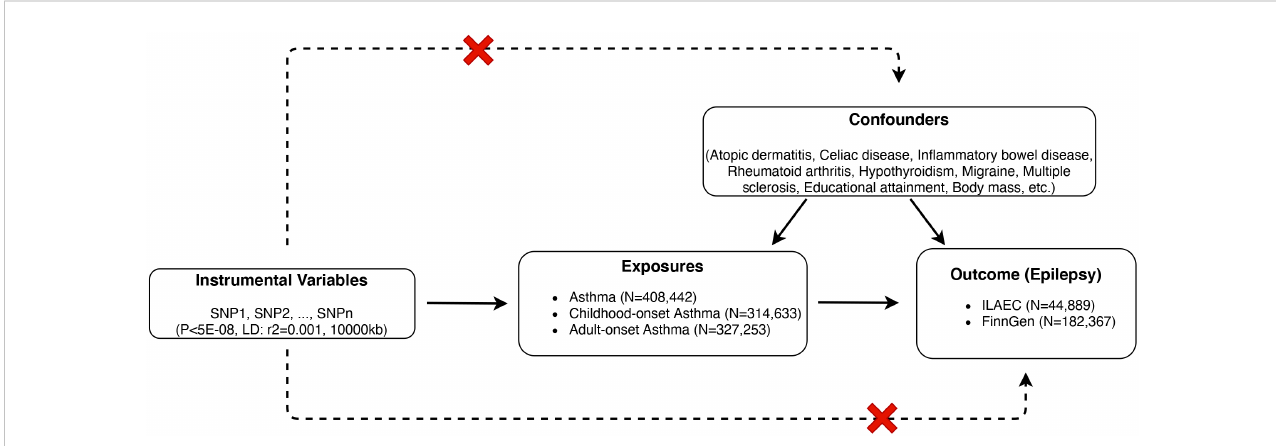
FIGURE 1 Three corresponding principal assumptions in this 2-sample Mendelian randomization study. Red stars mean that genetic variants are not associated with confounding factors and the